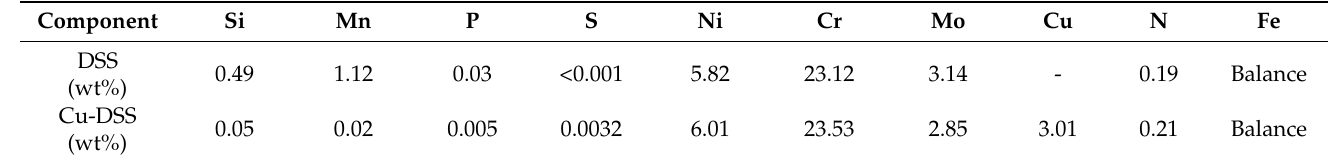
Table 1. Chemical compositions of 2205 DSS and 2205-Cu